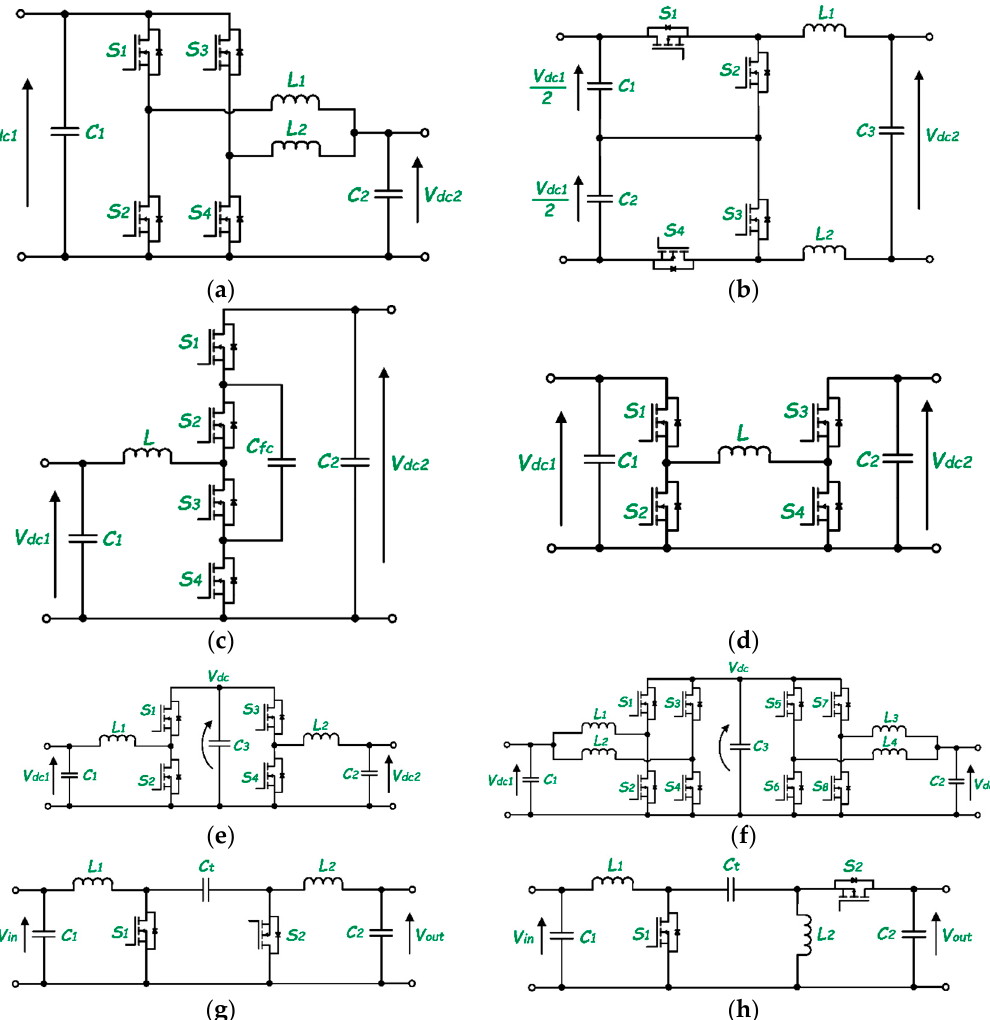
Figure 8. Non-isolated DC–DC converters: ( a ) interleaved buck converter; ( b ) three-level NPC boost converter; ( c ) three-level flying capacitor boost converter; ( d ) cascaded buck–boost converter; ( e ) split-pi converter; ( f ) interleaved split-pi converter; ( g ) Cuk converter; ( h ) combined SEPIC/zeta converter.